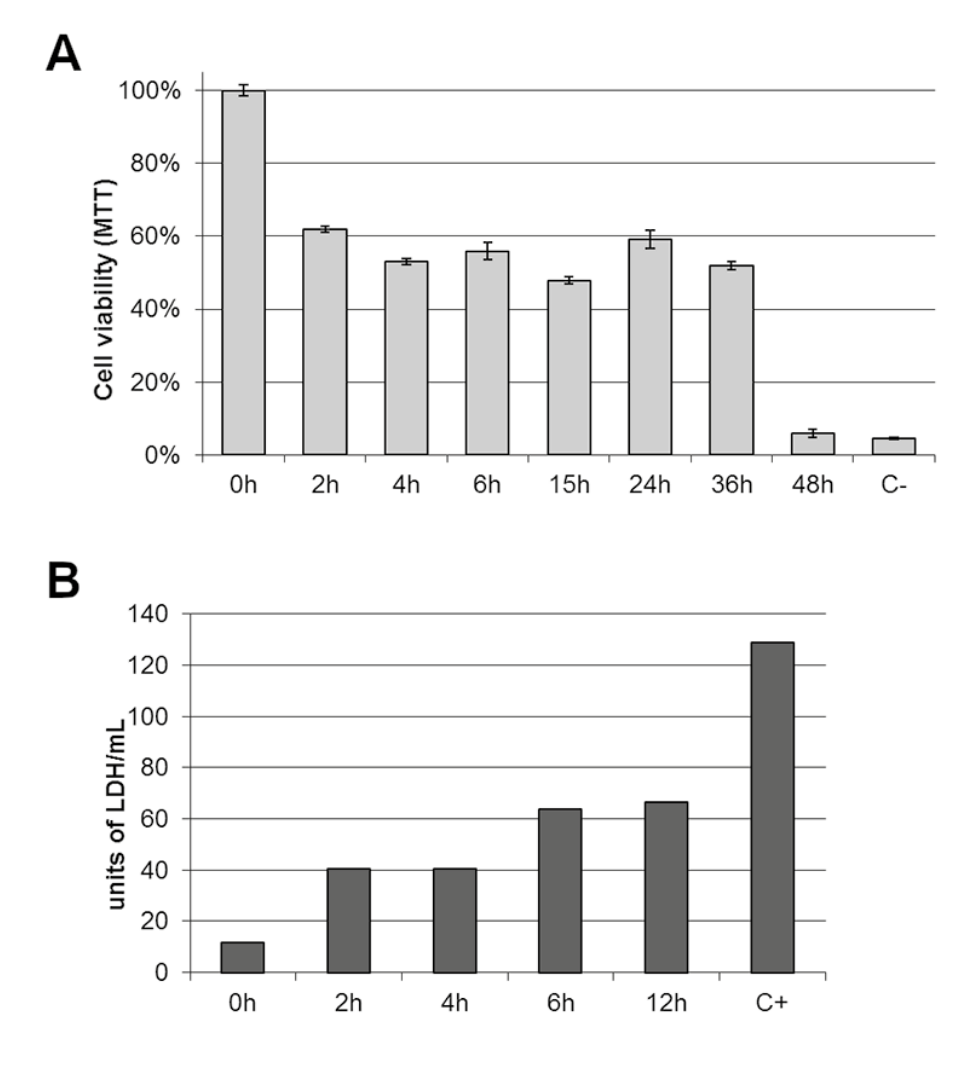
Figure 4. ECVF affects the mitochondrial activity and causes injury in membrane integrity in CEF cells. (A) MTT assay shows that CEF viability decreases to 60% after 2 hours of incubation with ECVF. Performed in triplicates. (B) Membrane integrity was lost and LDH had a maximum release after 6 hours of ECVF incubation (C+ represents the total LDH release after SDS